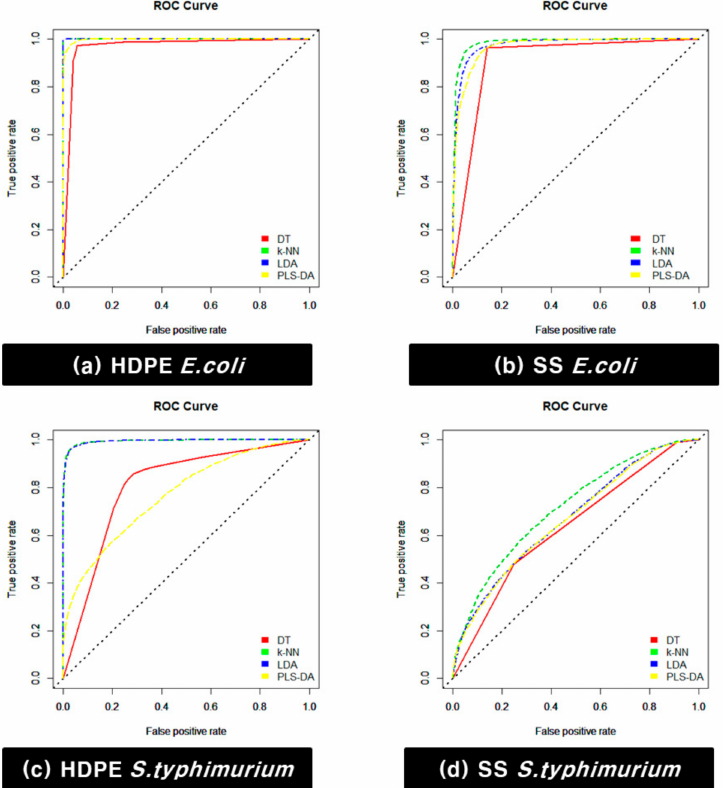
Figure 9. Receiver operating characteristics (ROC) curve of the discriminant model: ( a ) E. coli cultivated on HDPE, ( b ) E. coli cultivated on SS, ( c ) S. typhimurium cultivated on HDPE, and ( d ) S. typhimurium cultivated on